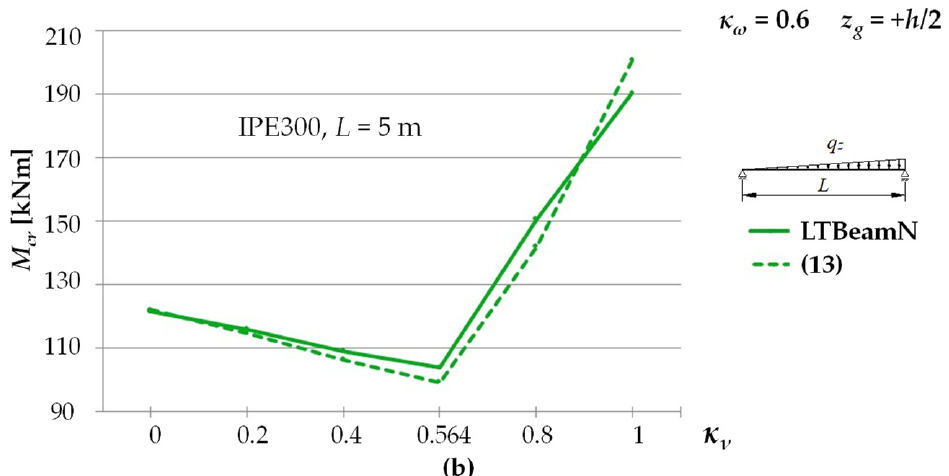
Figure 7. Comparison of graphs showing the variation in LTB critical moments M cr , determined by LTBeamN program and calculated with Equation (13): ( a ) a concentrated force load and a uniform load; ( b ) a triangularly distributed load.